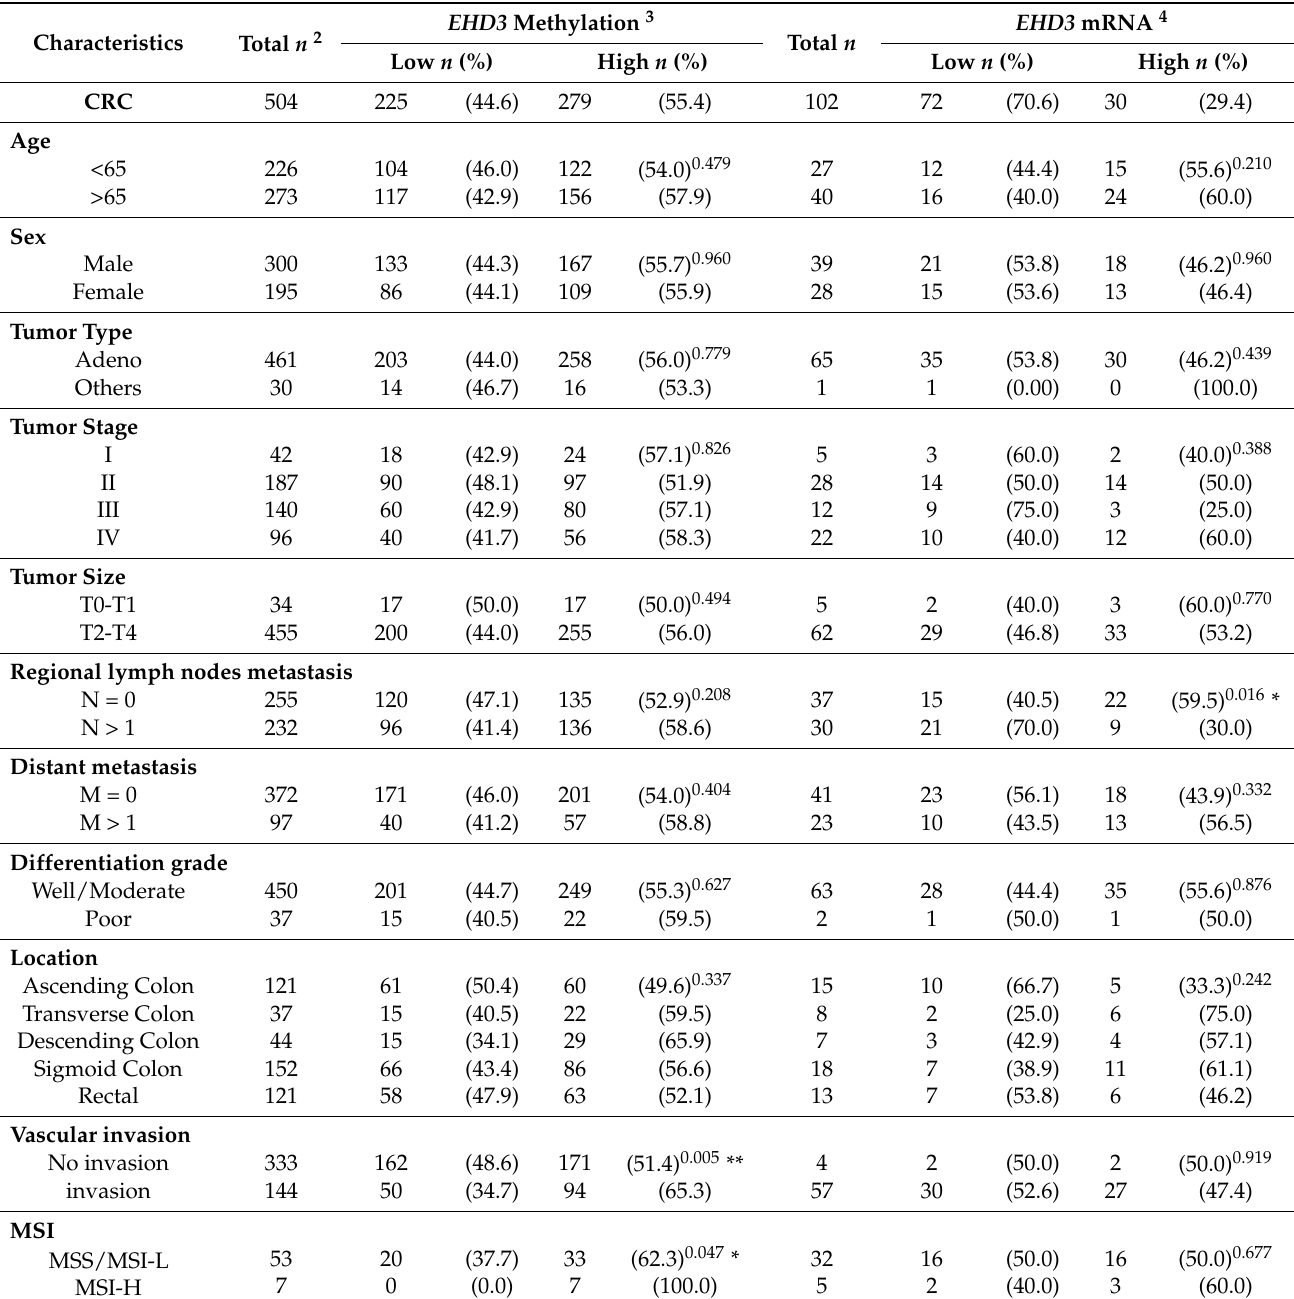
Table 1. EHD3 promoter hypermethylation and mRNA expression in relation to the clinical parameters of CRC in a Taiwanese cohort 1